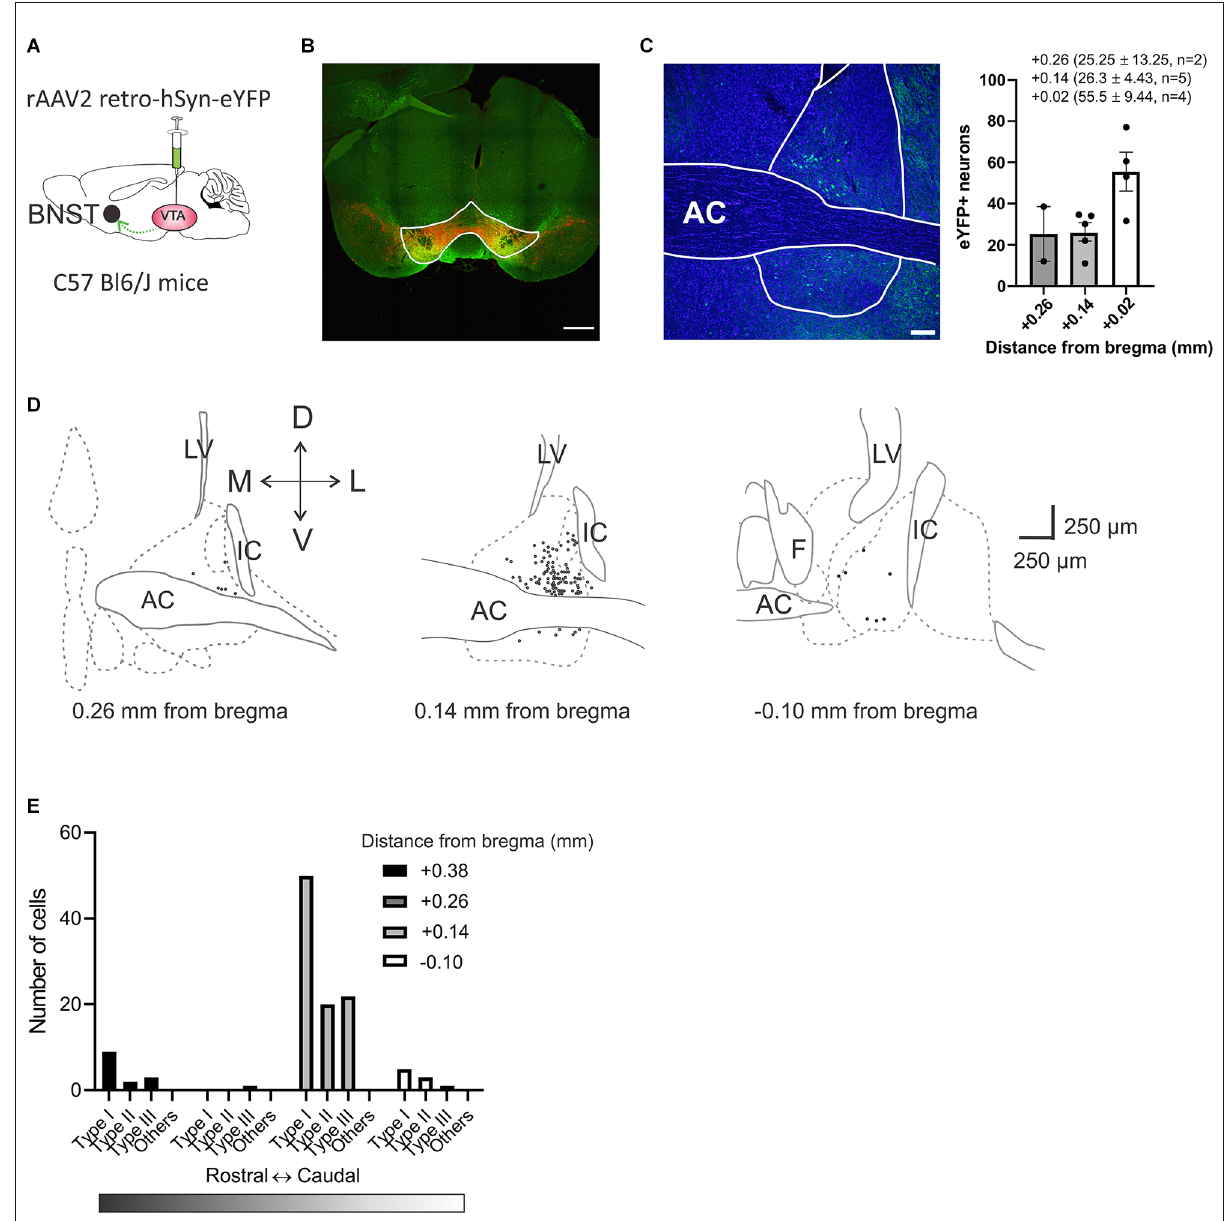
FIGURE1 AnatomicaldistributionofVTAprojectingBNSTneuronsacrosstheBNST. (A) Schematicdiagramofbilateralviralinjection.rAAV2retro-hSyn-eYFP was injected into the VTA of C57Bl6 male mice. The virus is taken up by axon terminals and transported retrogradely to cell bodies. (B) Image shows virally-mediated eYFP expression (green) in VTA injection site with tyrosine hydroxylase (TH, red). Scale bar 500 µ m. (C) Retrogradely labeled VTA projecting neurons were localized by rAAV2 retro-hSyn-eYFP expression in the BNST. Scale bar 100 µ m. (D) Anatomical distribution of recording sites of VTA projecting BNST neurons. BNST neurons that project to the VTA neurons were mainly localized in dorsolateral BNST +0.14 mm from bregma (Paxinos and Franklin, 2008). (E) Distribution count of recorded neurons across the BNST. AC, anterior commissure; LV, lateral ventricles; IC, internal capsule; F, fornix; BNST, bed nucleus of the stria terminalis; VTA, ventral tegmental area.